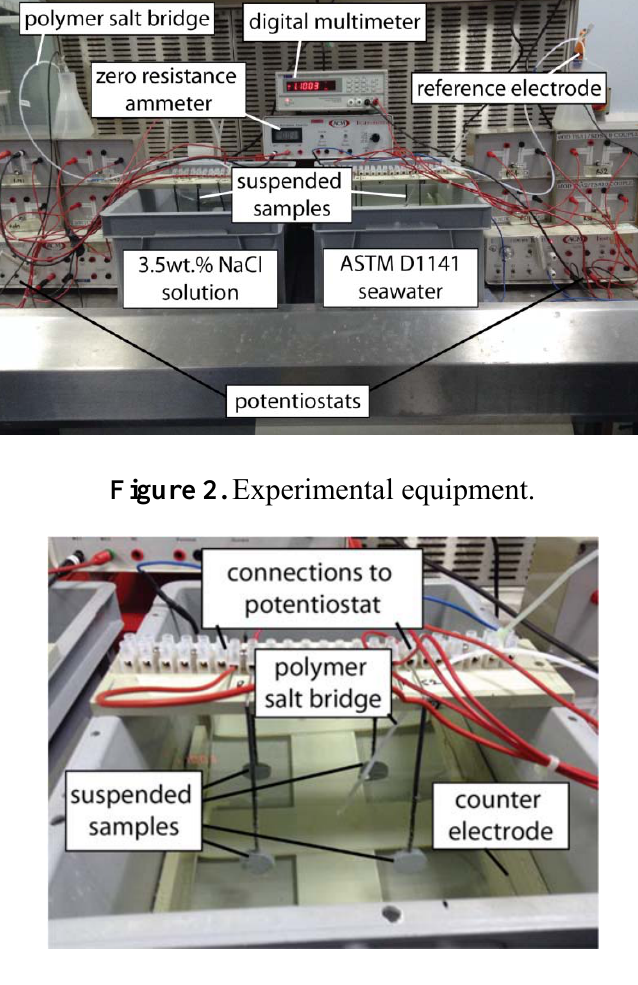
Figure 3. The tank